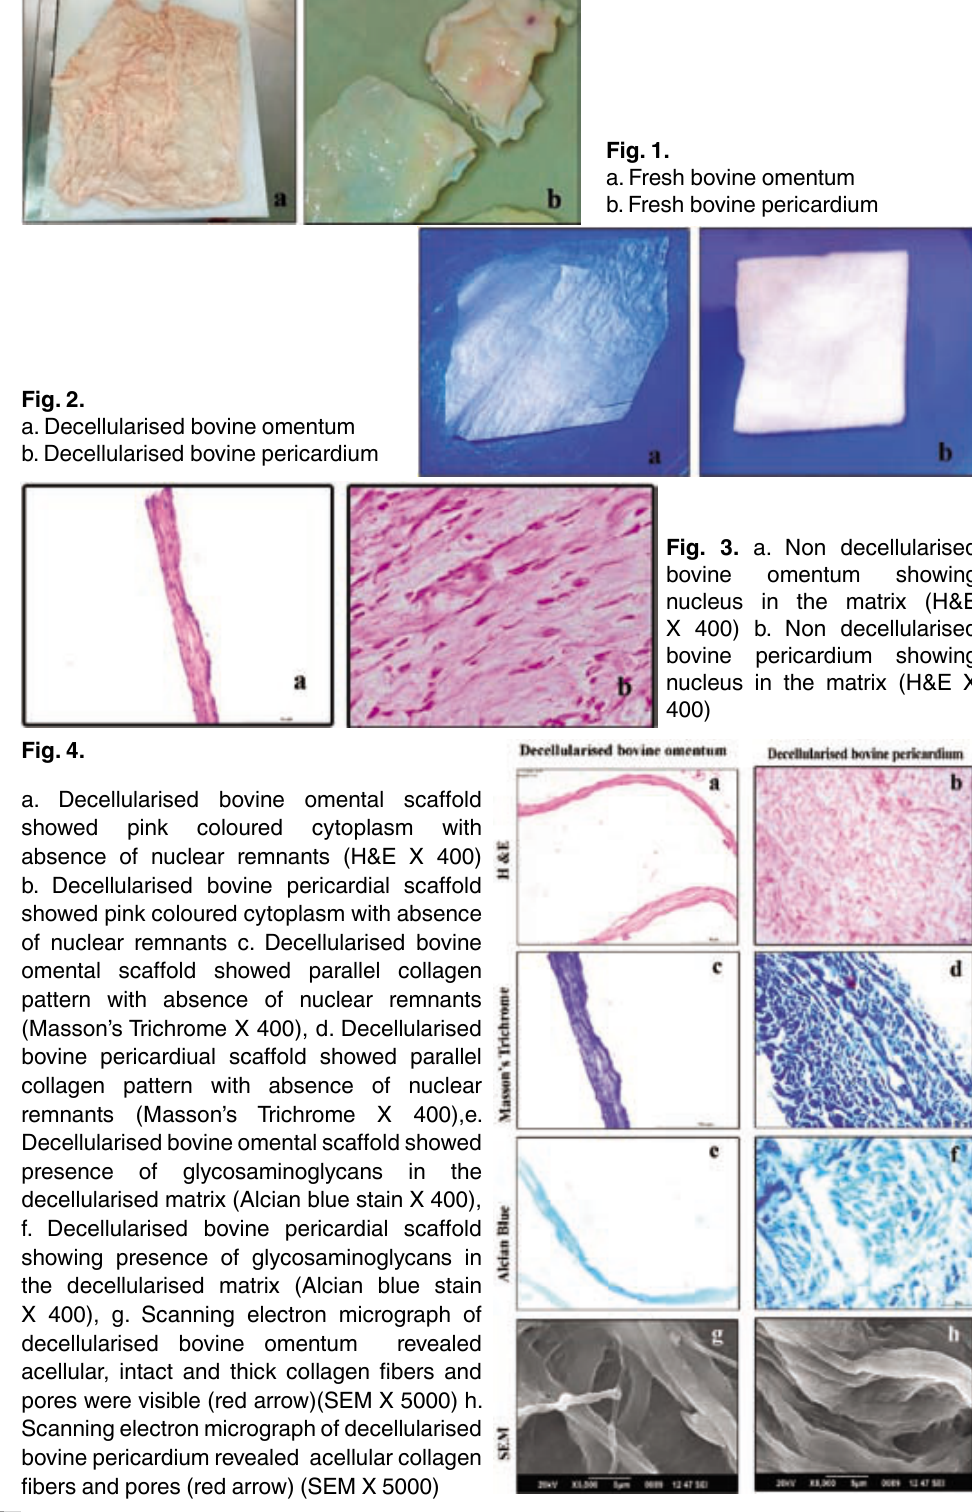
Fig. 2. a. Decellularised bovine omentum b. Decellularised bovine pericardium